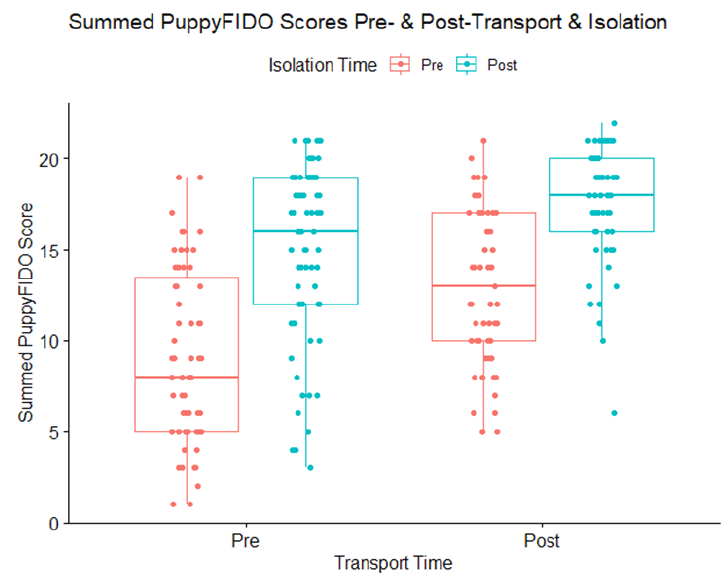
Figure 5. Summed scores for puppies tested with the PuppyFIDO tests pre- and post-isolation (isolation time) and transport to the distributor (transport time). Higher scores represent more affiliative behaviors in response to a stranger approaching.